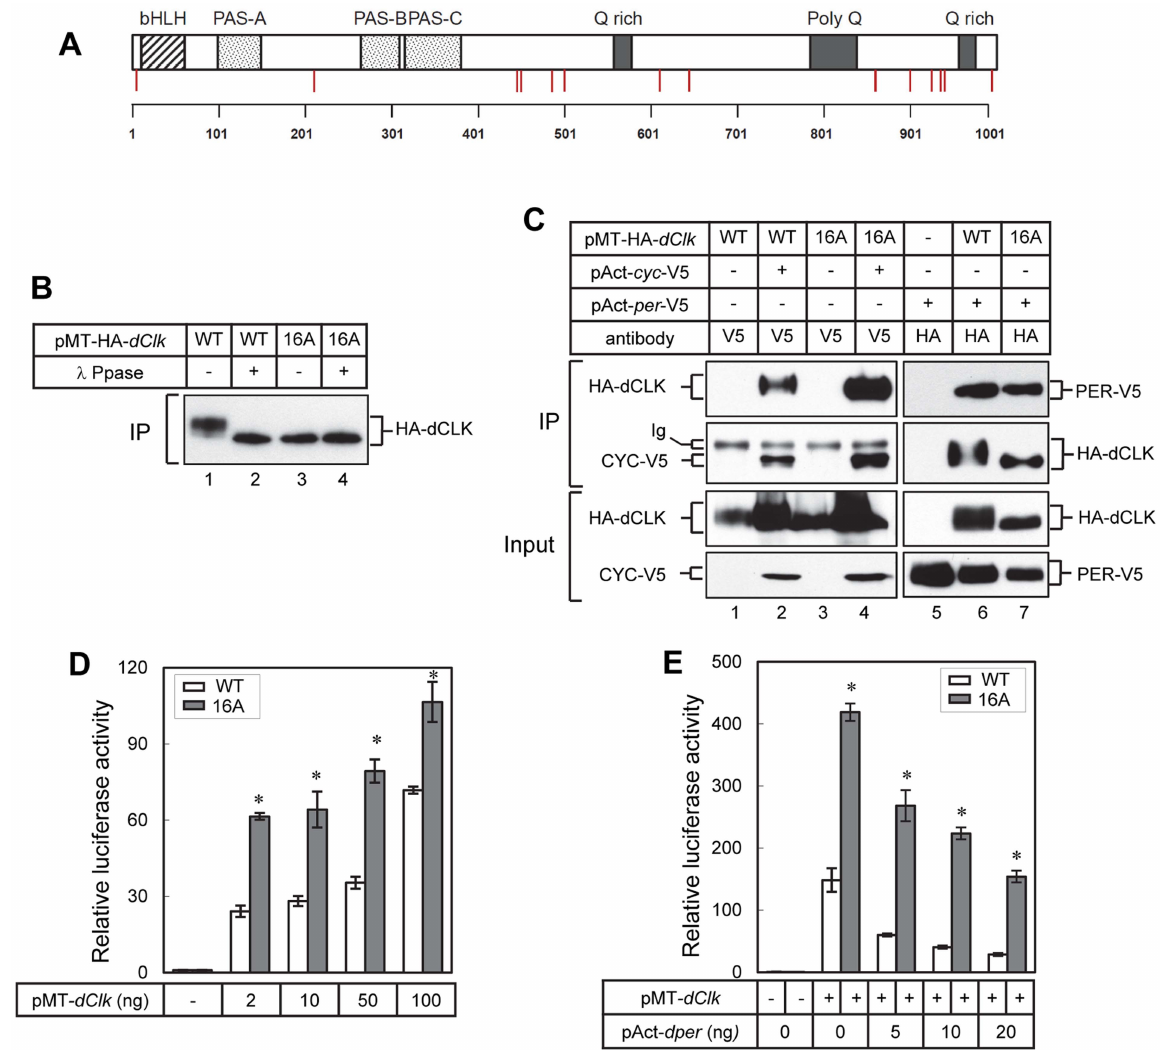
Figure 1. Blocking phosphorylation at multiple phospho-sites on dCLK prevents global phosphorylation but does not impair several key clock-relevant activities. (A) Schematic diagram of dCLK protein. Phosphorylation sites on dCLK identified in this study are indicated as red vertical lines. Horizontal line at bottom indicates relative positions of amino acid residues. (B, C) S2 cells were transiently transfected with 500 ng of pMT-HA- dClk (WT) or pMT-HA- dClk -16A (16A), either singly or in combination with 500 ng of pAct- cyc -V5 or pAct- per -V5 as indicated. Expression of dCLK was induced 24 hr after transfection by adding 500 m M CuSO 4 to the medium. Cells were harvested 24 hr after induction, and protein extracts were first subjected to immunoprecipitation using anti-HA (12CA5) antibody (B), the anti-epitope tag antibodies (V5 or HA) as indicated on top of the blots (C). Immune complexes were directly analyzed by immunoblotting (C) or further incubated in the absence ( 2 ) or presence ( + ) of l phosphatase followed by immunoblotting (B). (D, E) S2 cells were transiently co-transfected either singly with pMT- dClk -V5 (WT) and pMT- dClk -16A-V5 (16A) (D), or in combination with increasing amount of pAct- per (E). Shown are the average values from three independent experiments for relative E box dependent luciferase activity in the absence ( 2 ) or presence ( + ) of pMT- dClk -V5. *p , 0.05; error bars denote